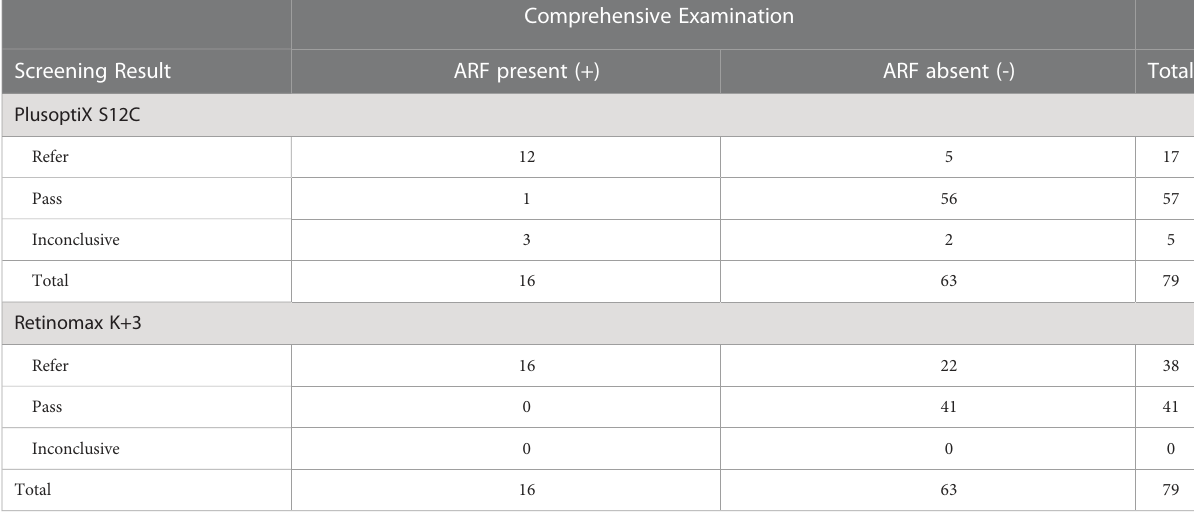
TABLE 2 Screening Results of Examined